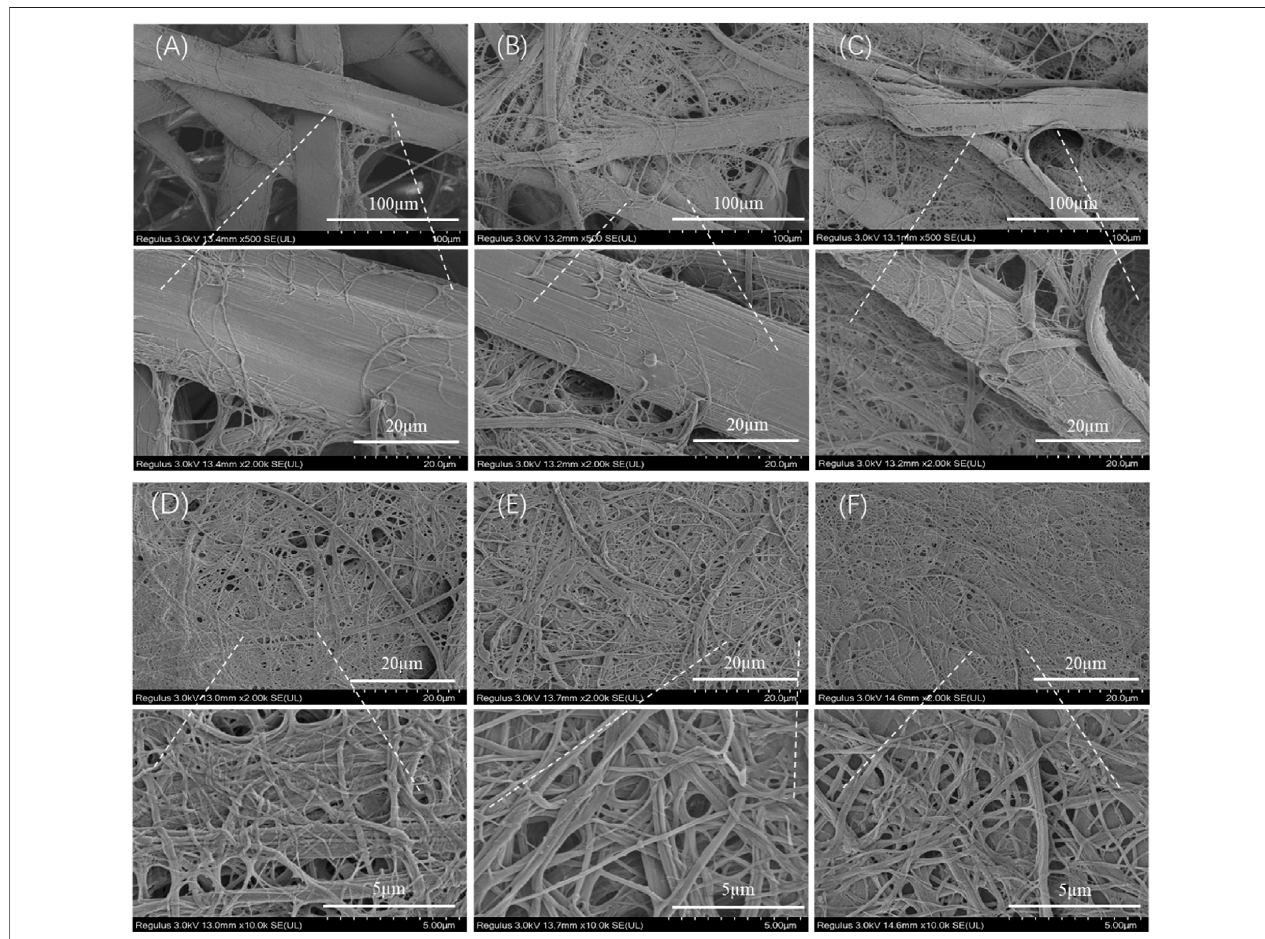
FIGURE 2 | SEM observation of the downsizing process of tussah silk with shear times: 2 min (A) , 4 min (B) , 8 min (C) , 10 min (D) , 20 min (E) , and 30 min (F) .